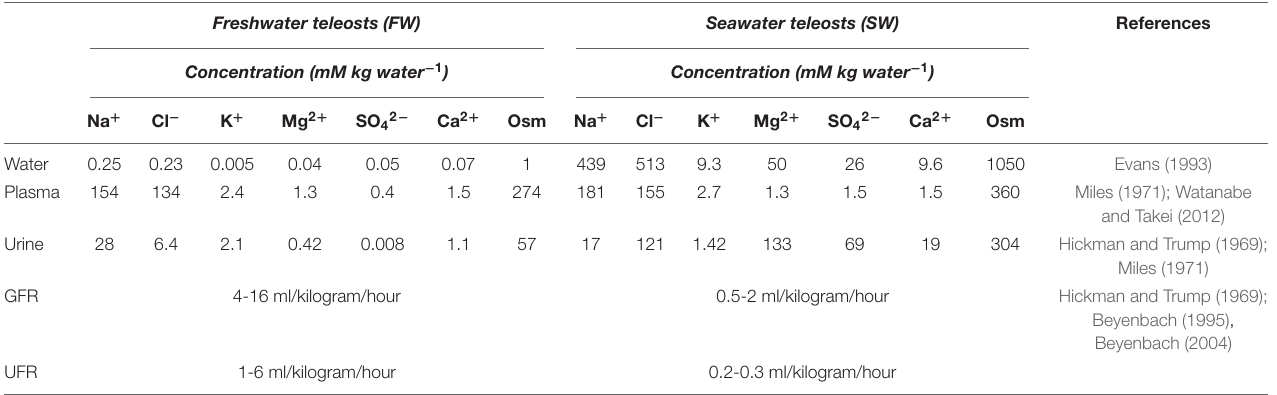
TABLE 1 | Ion composition and osmolality (Osm) in freshwater (FW) and seawater (SW) and in blood plasma and urine in FW and SW